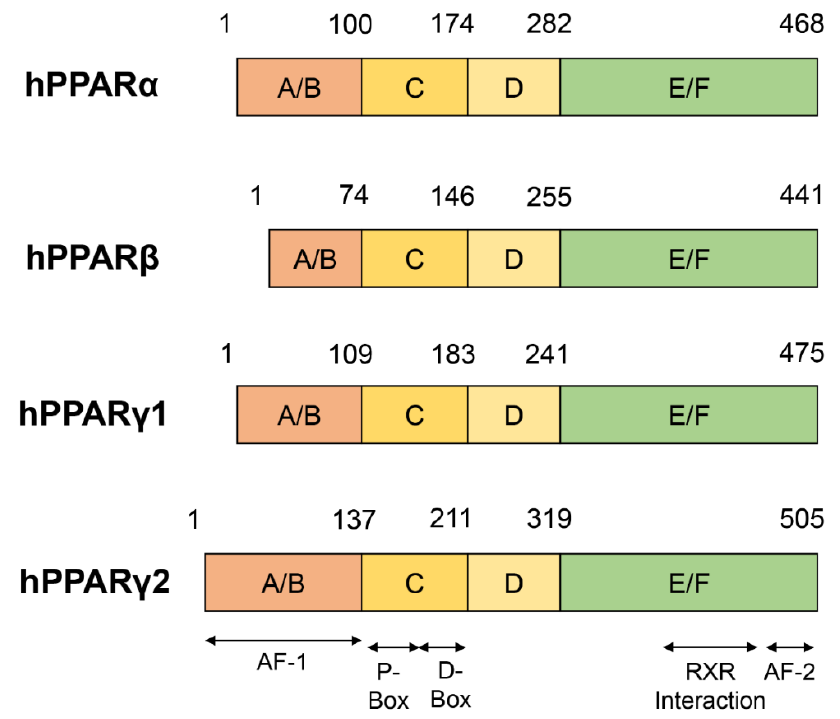
Figure 1. Schematic representation of the principal domains of PPARs. PPAR α , PPAR β , and PPAR γ all have a modular structure that contains four domains: A/B domain, C domain, D domain, and E/F domain. The A/B domain contains an AF-1 region involved in the regulation of PPARs phosphorylation. The C domain is the DNA binding domain. The D domain is a hinge domain. The E/F domain contains an AF-2 region and is the RXR, ligand, and cofactor binding site. The heterodimer of PPAR and RXR is considered a permissive dimer because activa- tion of either component can activate the entire complex. The PPAR/RXR heterodimer binds to the target gene promoter, PPRE. In the non-liganded state, PPAR/RXR interacts with co-repressors such as SMRT and NCoR to recruit repressors that contain histone